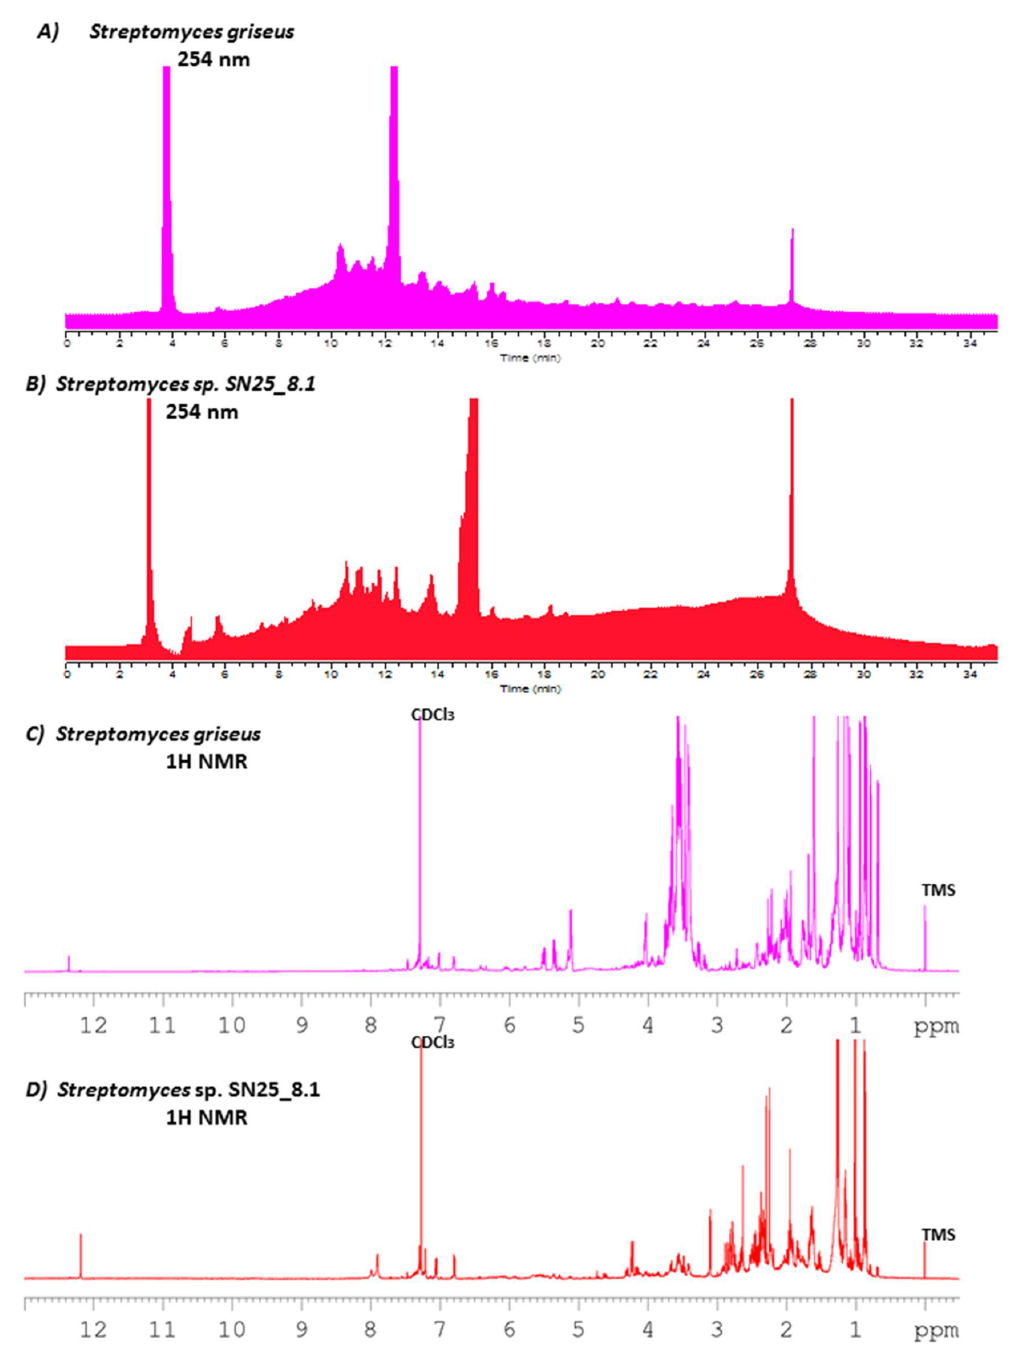
Figure 3. HPLC metabolite profile comparison of Streptomyces sp. SN25_8.1 from Easter Island, and Streptomyces griseus subsp. griseus DSM 40236 T from Russia, measured at 254 nm ( A , B ), and 1 H NMR comparison of the crude extract of both strains ( C , D ). CDCl 3 : deuterated chloroform; TMS: tetramethylsilane.